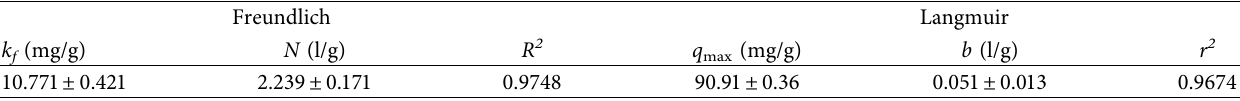
Table 3: Maximum adsorption capacity of Zn(II) with diferent microbial biomasses.